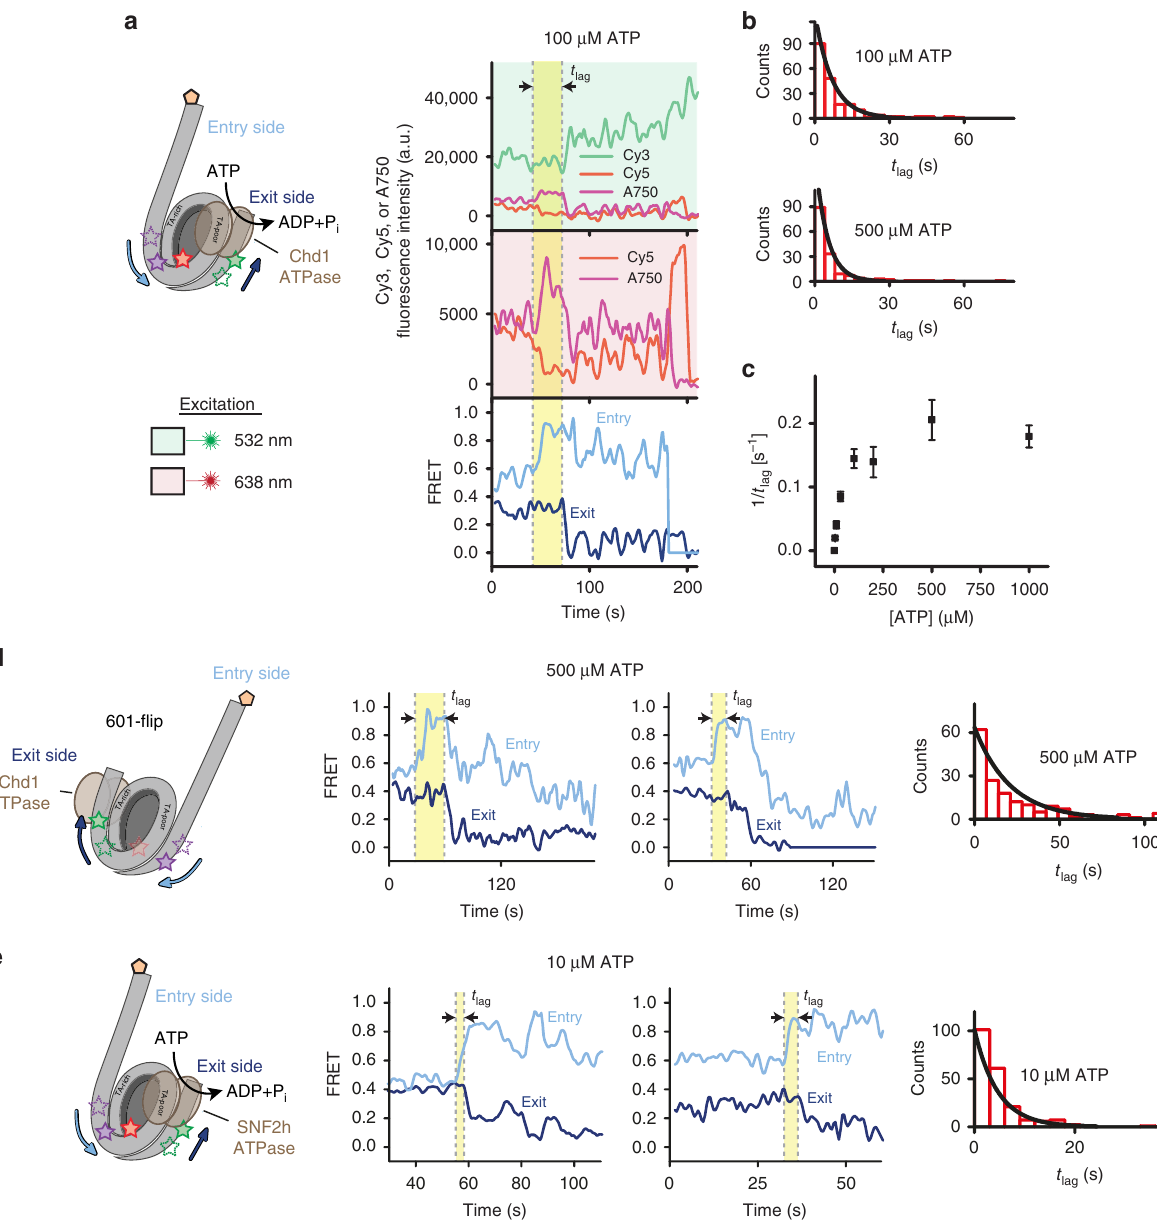
Fig. 2 Entry-side movement of nucleosomal DNA precedes exit-side movement. a Cy3 (green), Cy5 (red), and Alexa750 (purple) fl uorescence and FRET time traces (exit-side: dark blue; entry-side: light blue) showing sliding of a single nucleosome, after addition of 300 nM Chd1 and 100 μ M ATP. The lag time between the onset of entry- and exit-side DNA movements is denoted as t lag . Time traces were recorded with alternating 532 nm and 638 nm laser excitation, as indicated by the areas shaded in green and red, respectively. b Histograms of t lag values (red bars) observed with 100 or 500 μ M ATP, fi t with a single-exponential distribution ( N = 185 – 220 events). c Dependence of 1/ t lag on the ATP concentration. Data are shown as the mean ± SEM ( N = 40 – 340 events). d Left: Cartoon schematic showing the 601- fl ip nucleosome, with short exit DNA on the TA-poor side and long entry DNA on the TA-rich side of the 601 sequence. Middle: Two representative FRET time traces (exit-side: dark blue; entry-side: light blue) showing sliding of single 601- fl ip nucleosomes after addition of 300 nM Chd1 and 500 μ M ATP. Right: Histogram of t lag values (red bars) from many 601- fl ip nucleosomes observed with 500 μ M ATP, fi t with a single-exponential distribution ( N = 190 events). e Nucleosome sliding by SNF2h shows the same coordination of entry/exit DNA movements. Middle: Two representative FRET time traces (exit-side: dark blue; entry-side: light blue) showing sliding of single nucleosomes after addition of 1 μ M SNF2h and 10 μ M ATP. Right: Histogram of t lag values (red bars) constructed from 226 events, fi t to a single-exponential distribution (black line). Source data are provided as a Source Data fi le